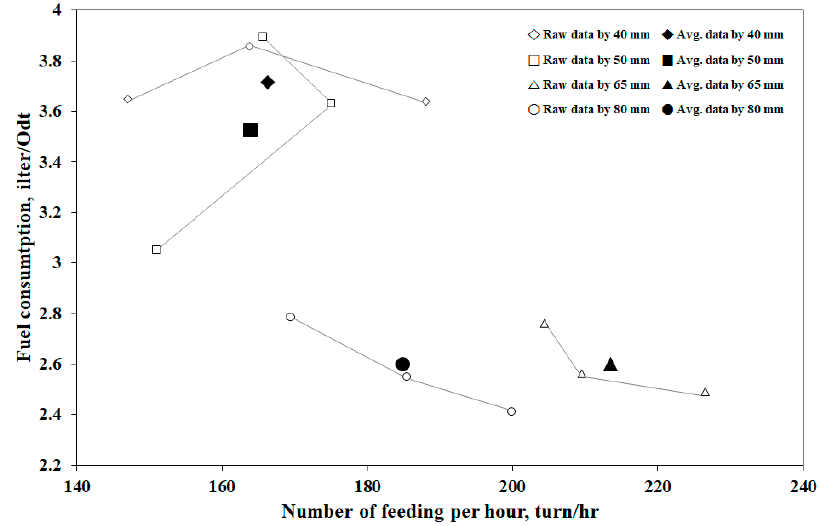
Figure 7. Analysis of the fuel consumption of the chipping operation by number of feedings per hour.